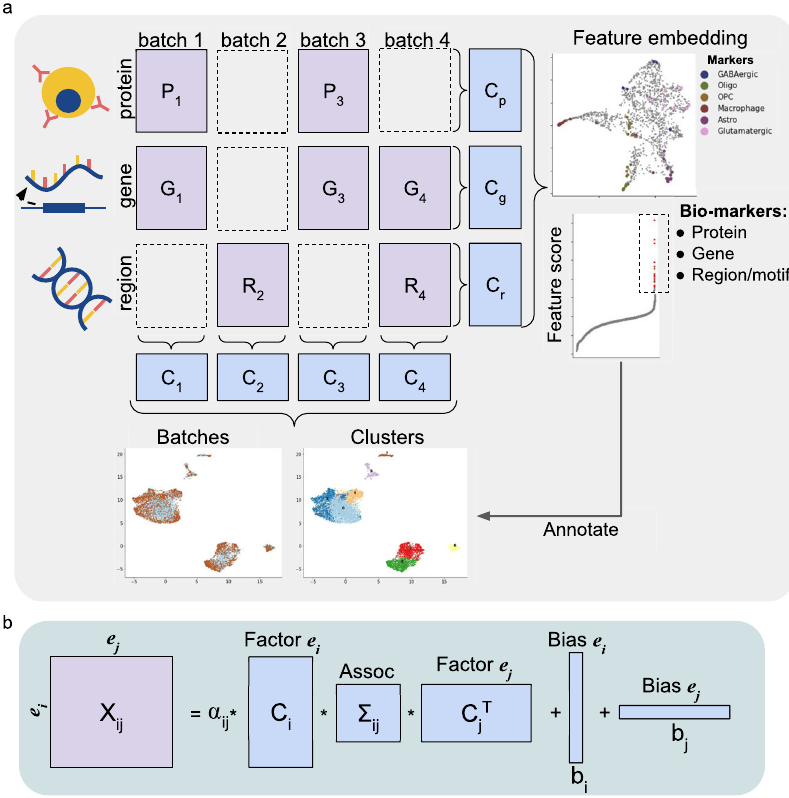
Fig. 1 | scMoMaT overview. a Graph illustration of running scMoMaT on an example dataset (4 batches and 3 modalities). Given data matrices in a mosaic layout to integrate, scMoMaT outputs cell representations and feature repre- sentations of multiple modalities, cell clusters and top-scoring bio-markers of